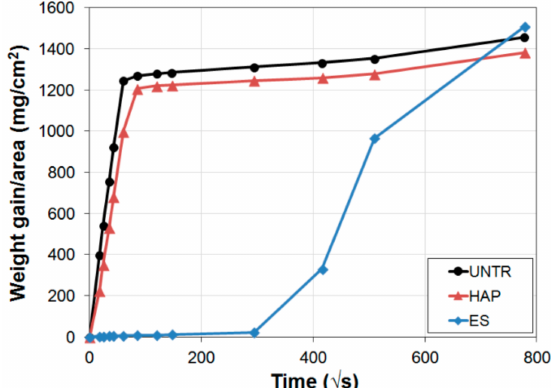
Figure 10. Alterations in water sorptivity of Globigerina limestone treated with a 3 M DAP solution, followed by a limewater poultice (“HAP”) and with a commercial ethyl silicate (“ES”), in comparison with the untreated reference (“UNTR”). Both consolidants were applied by brushing 10 times cubic samples (50 mm side) on a single face, through which water was then let penetrate by capillarity. The “ES” sample was left to cure for 1 month before testing. Image reprinted from Reference [49] with permission from